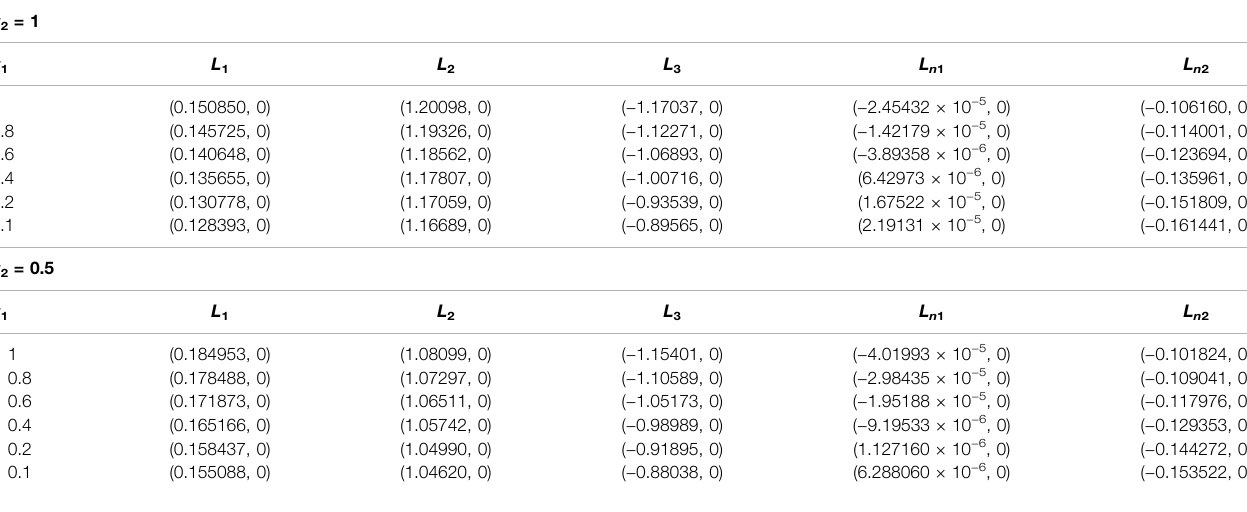
TABLE4| Positions( x 0 ,0)ofthecollinearpointsofthebinaryHD155876systemfor fi xedvalues M b =0.05, T =0.01, σ 1 =4×10 − 5 , σ 2 =3×10 − 5 , σ 1 ′ (cid:1) 2 × 10 − 5 , σ 2 ′ (cid:1) 10 − 5 , A 3 = 0.02, and for two fi xed values of q 2 when q 1 radiates.